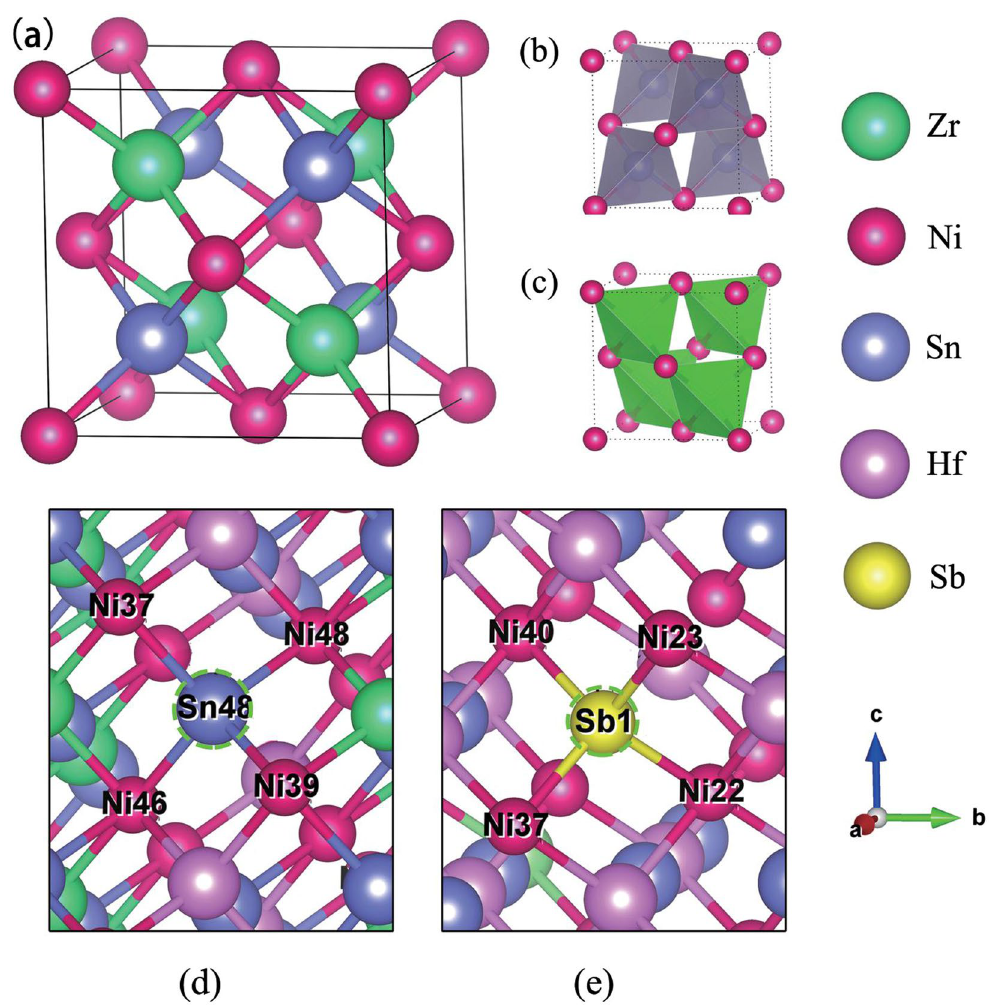
Figure 1. ( a ) The crystal structure of half-Heusler ZrNiSn with the space group of F m 43 , no. 216. Corner sharing of ( b ) SnNi 4 and ( c ) ZrNi 4 tetrahedra. ( d ) Local structure of Hf 0.5 Zr 0.5 NiSn. ( e ) Local structure of Hf 0.5 Zr 0.5 NiSn 0.98 Sb 0.02 .